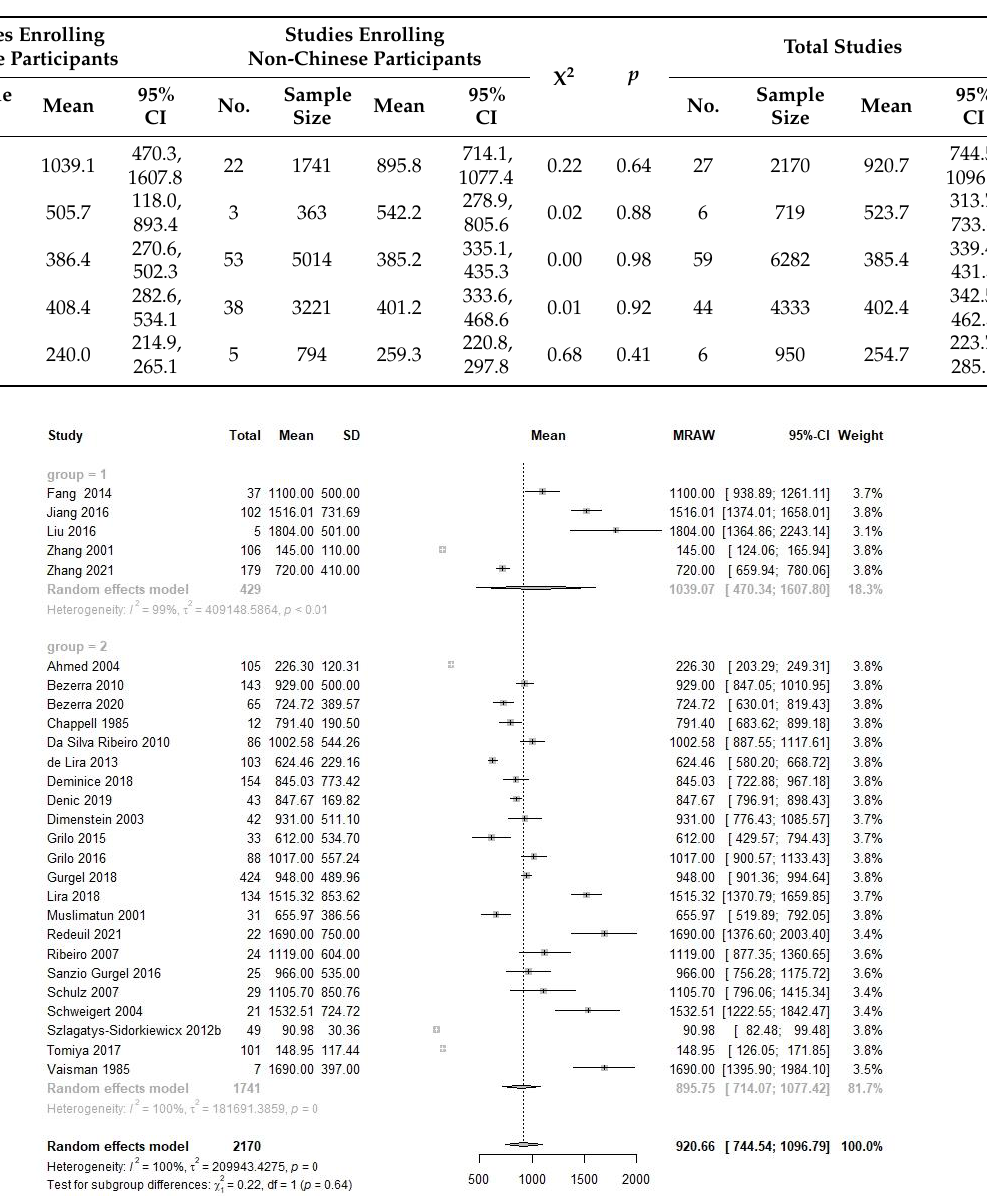
Figure 2. Forest plot of colostrum VA concentration and subgroup analysis between Chinese and non-Chinese samples.